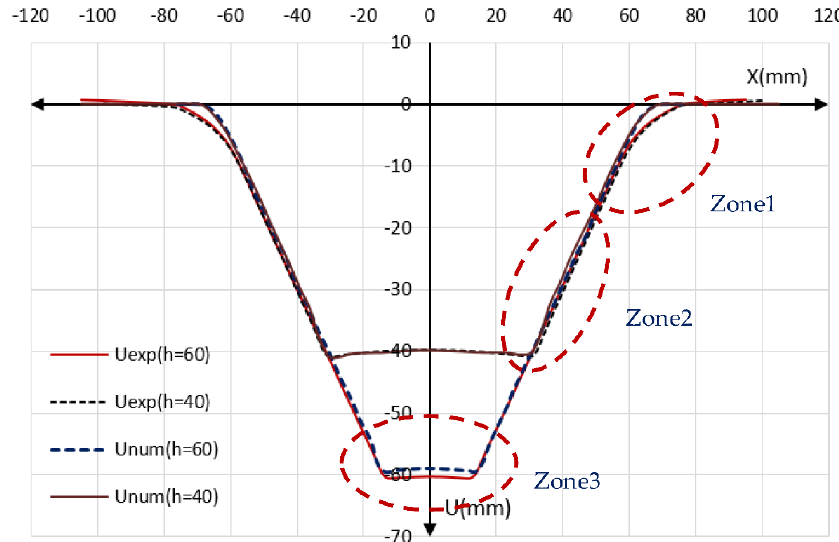
Figure 16. Experimental and FE numerical profile shapes for h = 60 m. Table 5. Summary of experimental and numerical results.